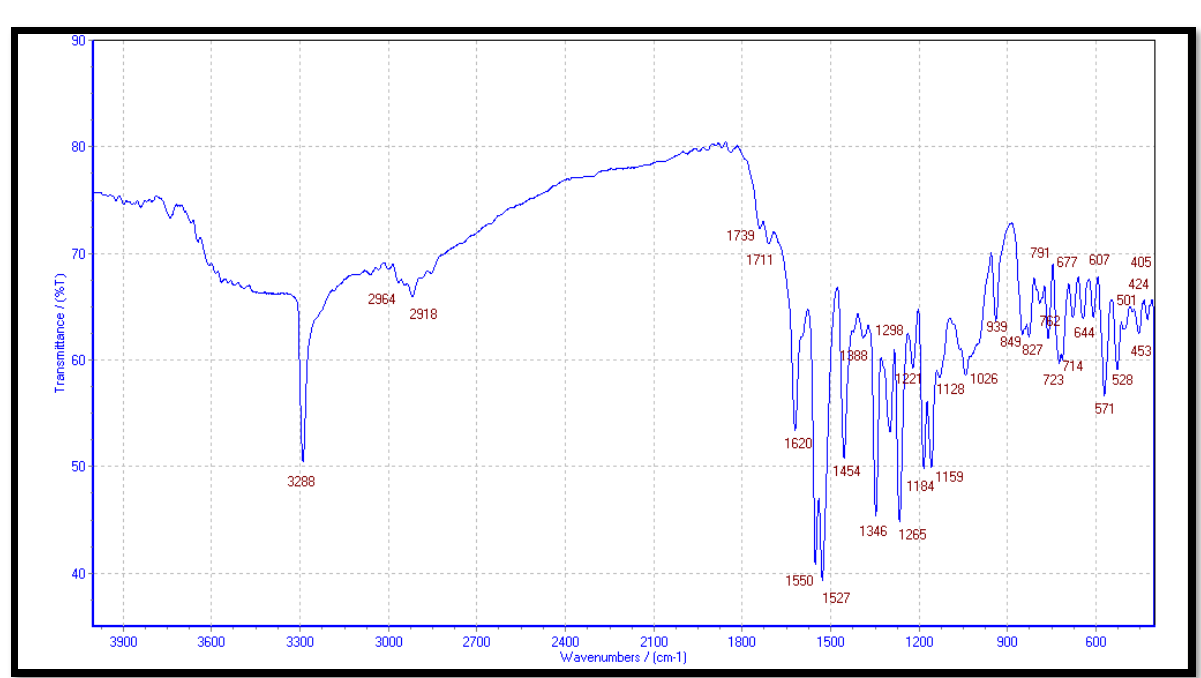
Figure 8. FTIR spectrum of